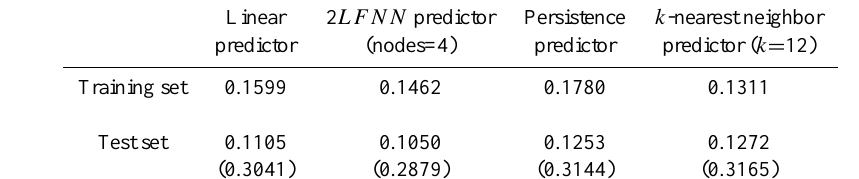
Table 1. Fifteen-minute ahead prediction. The table shows the mean square error on the training set and on the test set for the linear predictor, the 2LFNN predictor with 4 nodes in the hidden layer, the persistence predictor and the k -nearest neighbor predictor, for k = 12. In parentheses the standard deviation of the squared errors for each predictor on the test set is shown.